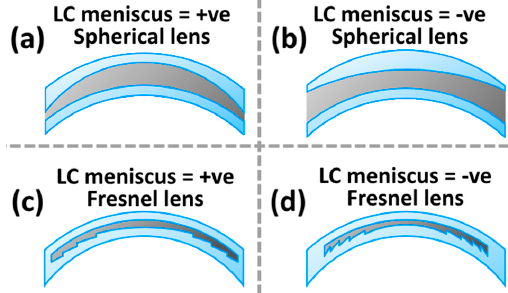
Figure 11. Comparison of simple lenses when constructed using a Plano-convex, or Fresnel lens substrate. The encapsulated LC layer forms the negative of the substrate’s lens shape. This enables the focal power to switch between 0D or ±2D if the lens is carefully designed.